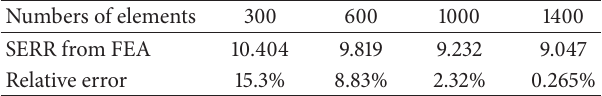
Table 1: The value of SERR for various numbers of